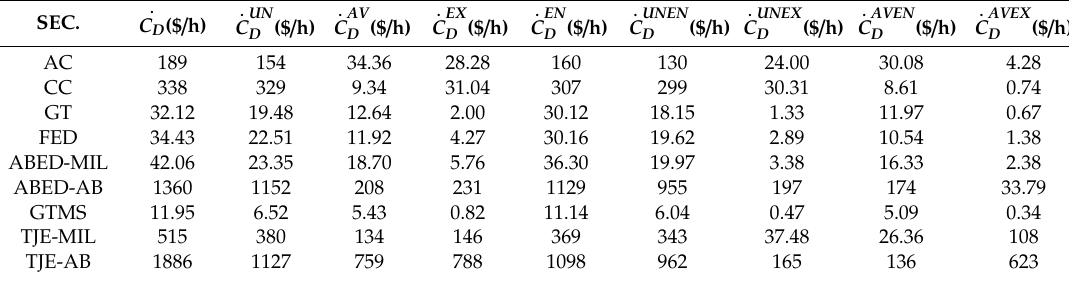
Table 15. Results for advanced exergy destruction costs for kerosene